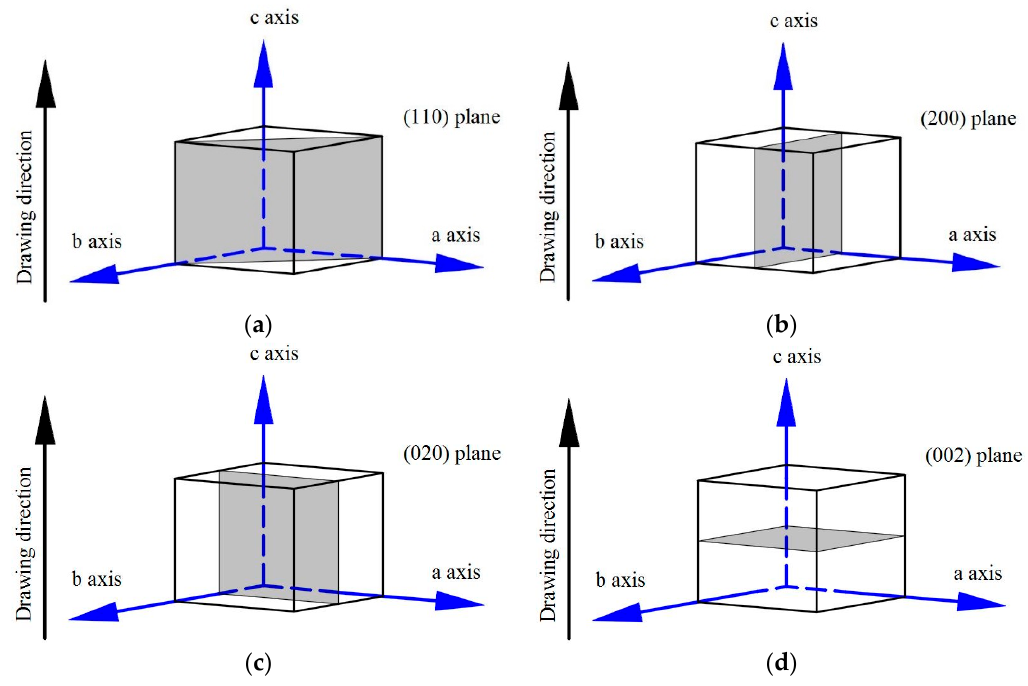
Figure 8. Plane orientation inside of orthombic unit cell: ( a ) (110) plane; ( b ) (200) plane; ( c ) (020) plane; and ( d ) (002) plane.